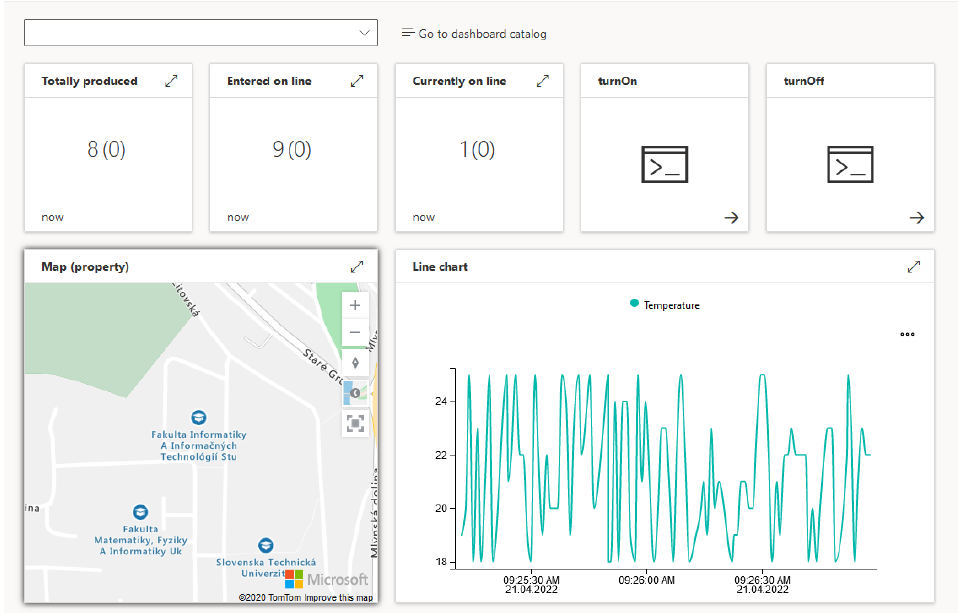
Figure 14. Dashboard in Azure IoT